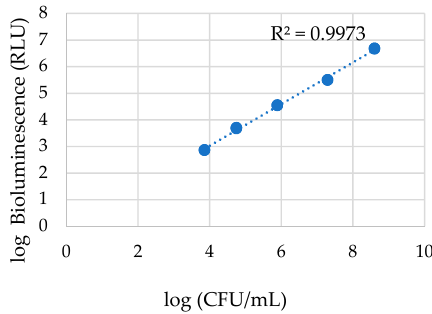
Figure 1. Correlation between bacterial cell density of E. coli bioluminescent (log of cell density, log (CFU/mL)), and the emitted luminescence detected by the luminometer (log of bioluminescence (RLU)).